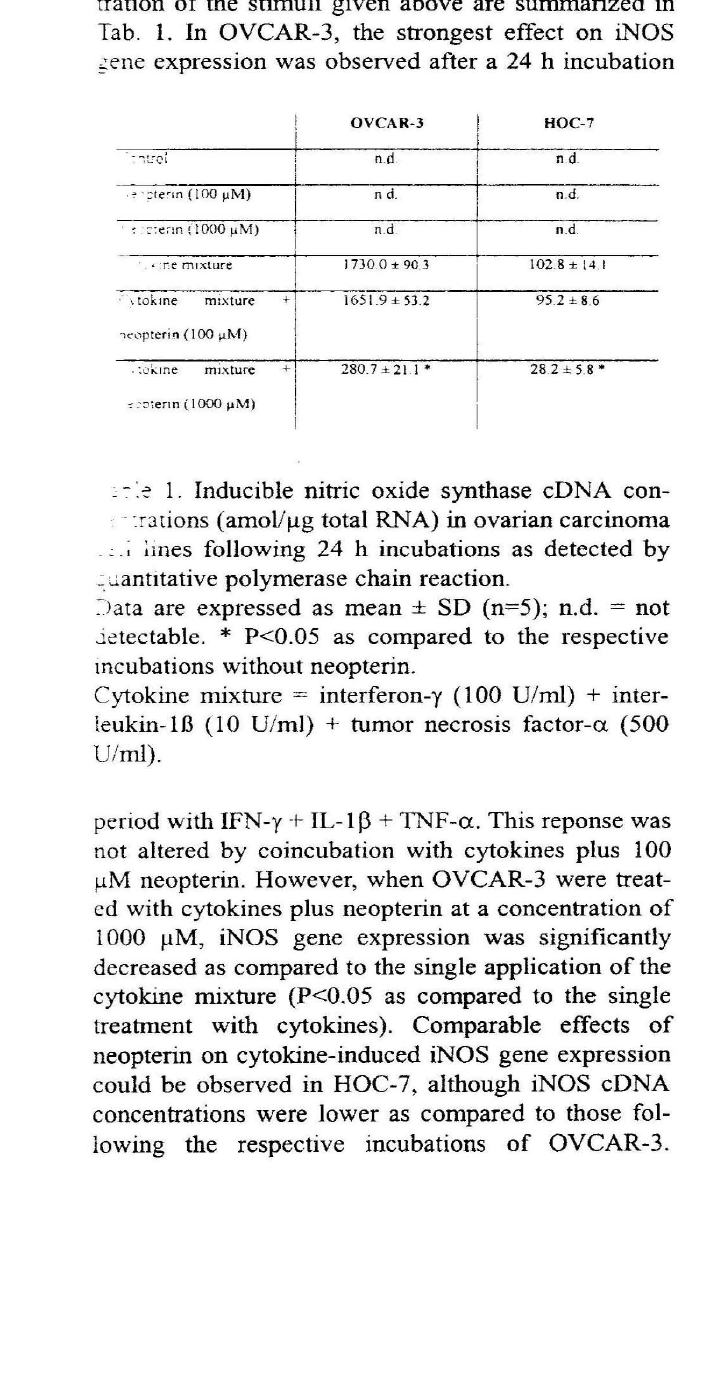
Tab. 1. In OVCAR-3, the strongest effect on iNOS